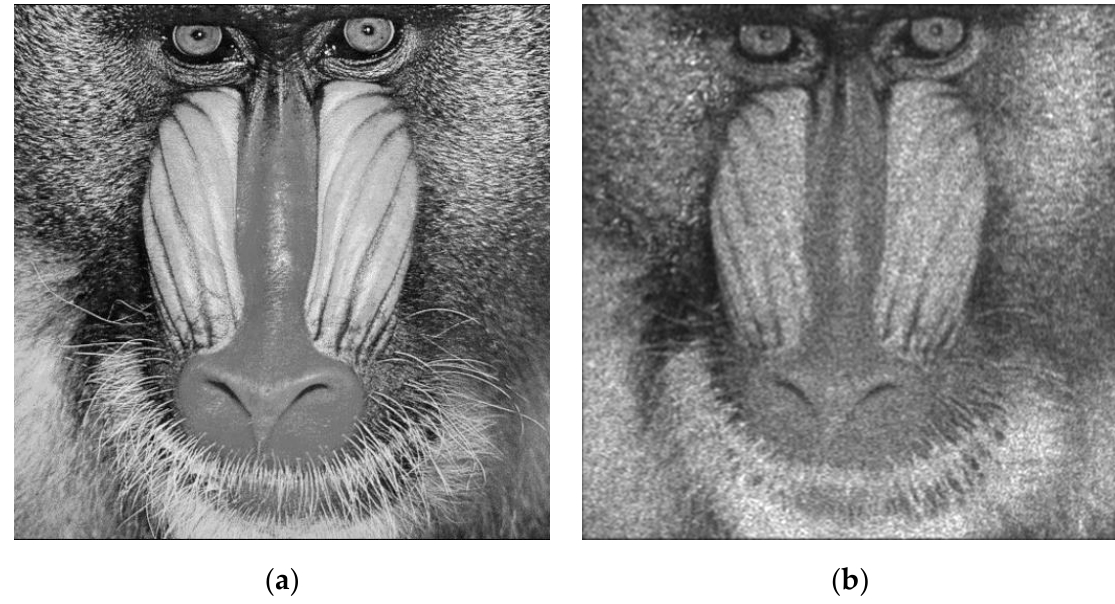
Figure 2. The ground truth image ( a ) and the reconstructed image ( b ) by 100 intensity accumulation of reconstructed images of RP binary CGHS. The PSNR of ( b ) is 17.86 dB.